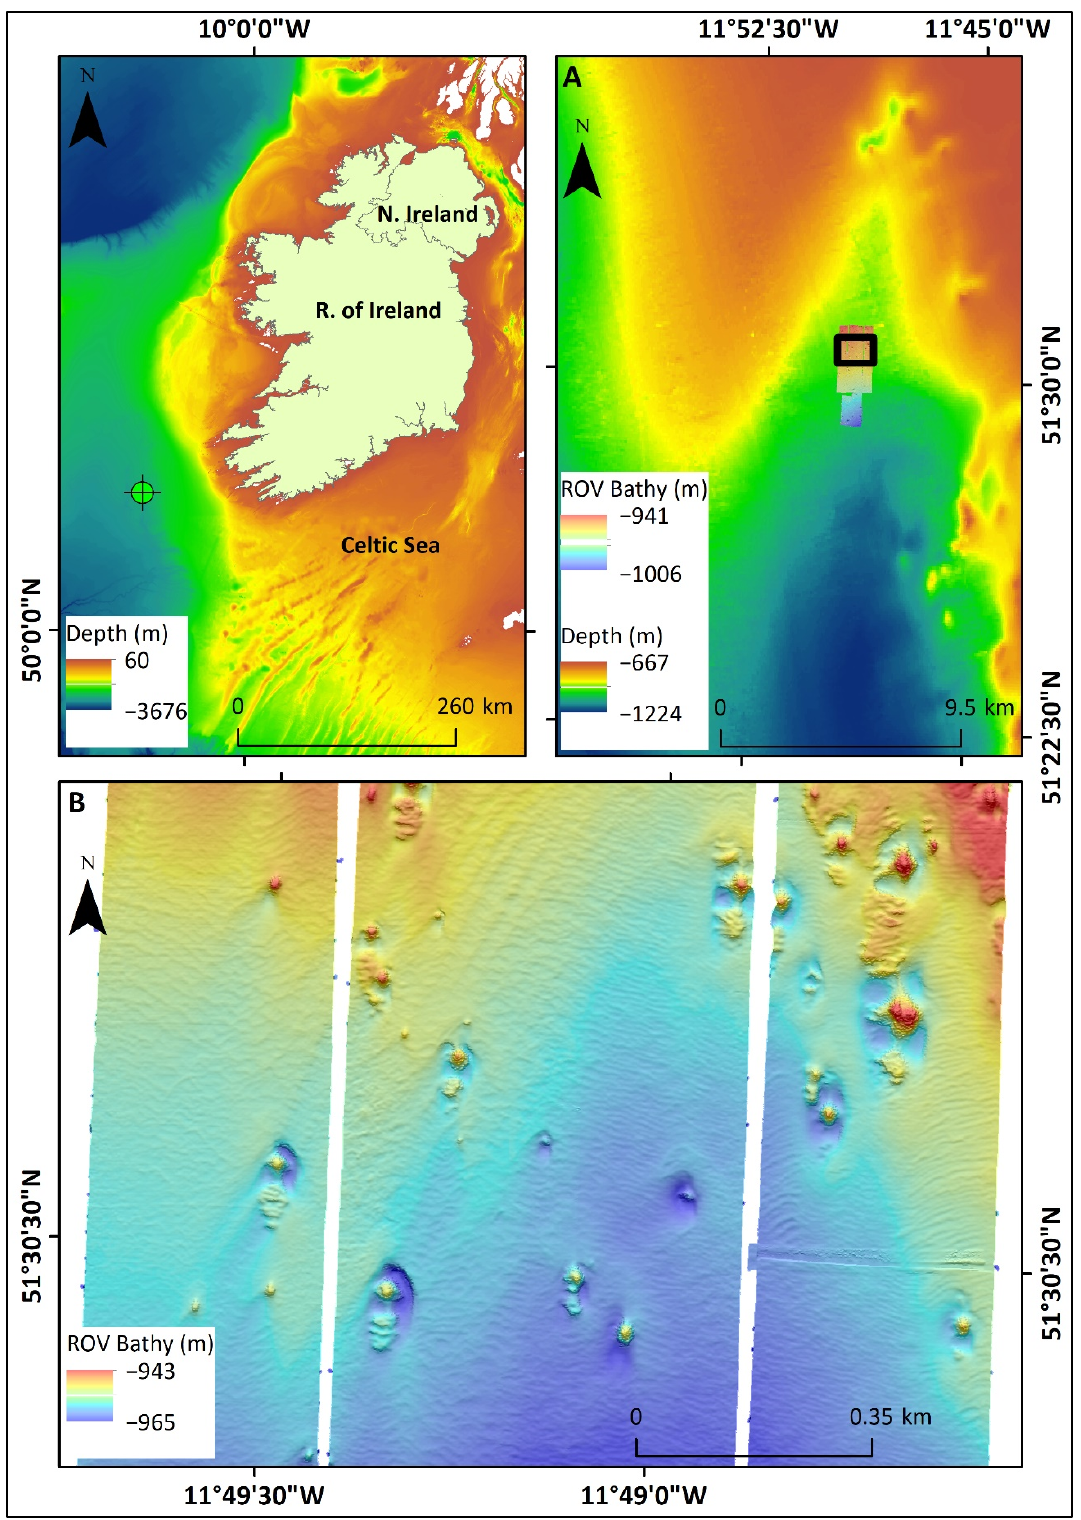
Figure 1. ( A ) Study site area. The bathymetry acquired in the downslope Moira Mounds region derived from remotely operated vehicle (ROV) based multibeam echosounder (MBES) data displaying the extent of ( B ) outlined in black, ( B ) moated cold-water coral mounds surrounded by mobile sediment worked into sediment waves. Coral ridges appear immediately south of the larger mounds.